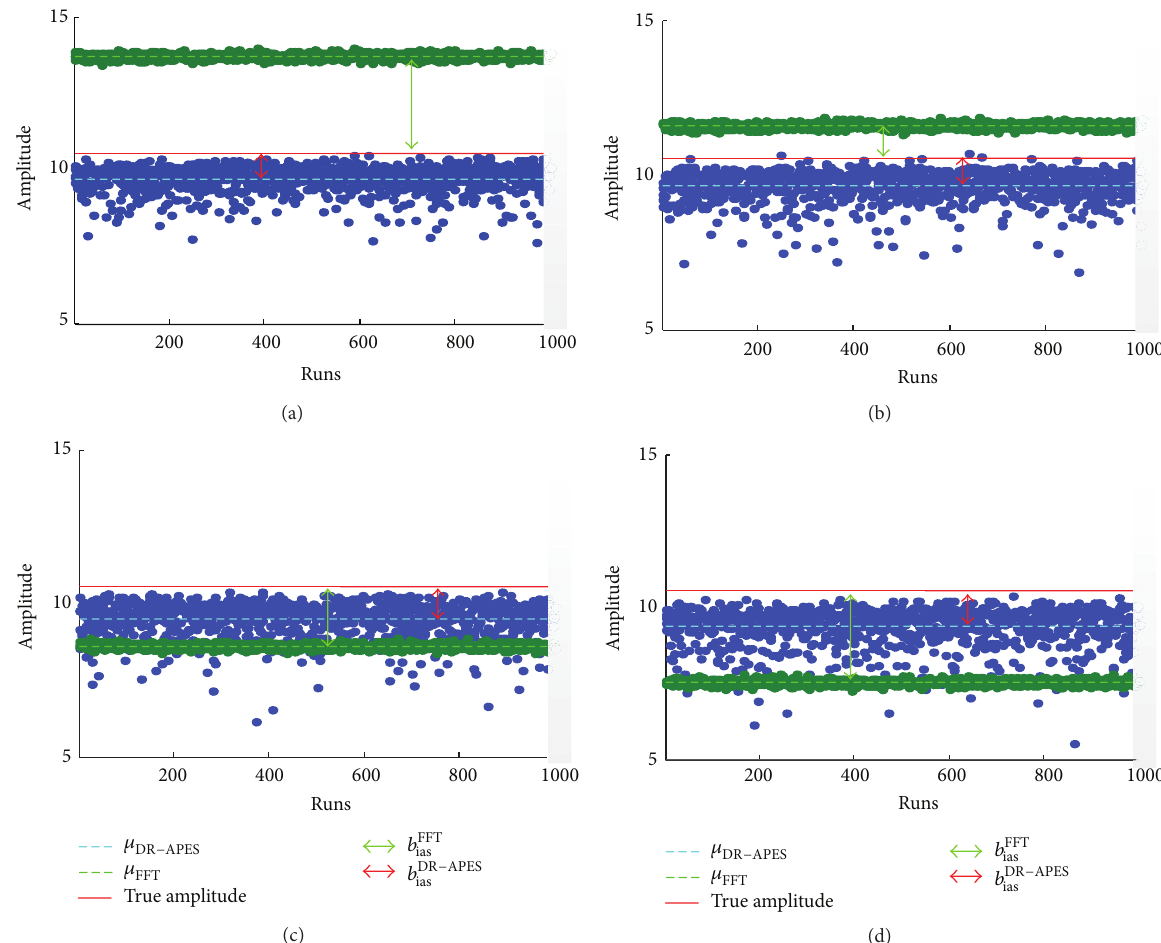
Figure 6: Scatterplot of the peak amplitude spectra given by DR-CAPES and FFT ((a) 𝜎 = 0.001 ; (b) 𝜎 = 0.0015 ; (c) 𝜎 = 0.0025 ; (d) 𝜎 = 0.003